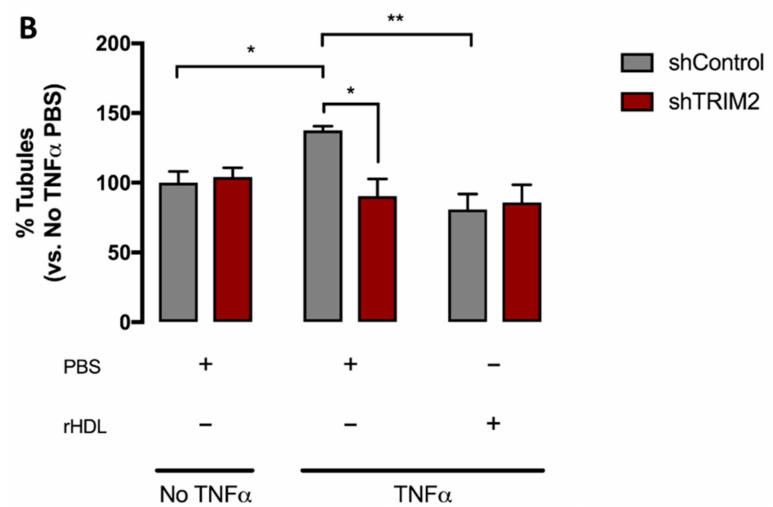
Figure 7. Tubulogenesis following TNF α stimulation in HCAECs transduced with lentivirus containing shControl or shTRIM2 treated with either PBS or rHDL compared to non-stimulated cells. ( A ) Representative images of tubule formation were photographed under light microscopy. Scale bars, 50 µ m; ( B ) Number of tubules was counted and analyzed using ImageJ software. Results are mean ± SEM. * p < 0.05, ** p < 0.01 by two-way ANOVA with post hoc analysis using Bonferroni’s multiple comparisons